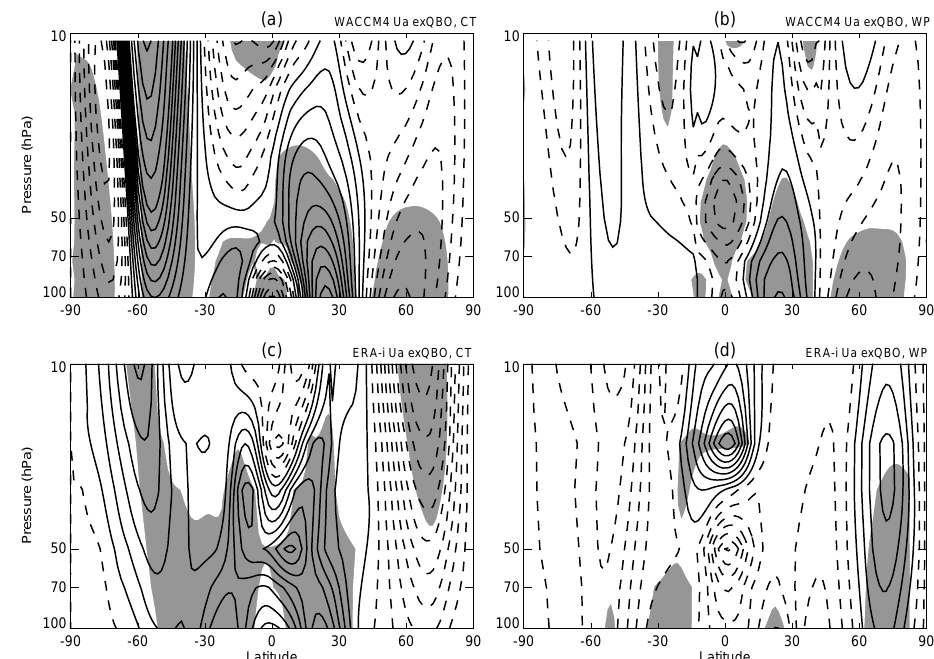
Figure 11. Differences of the zonal wind for (a) R5 – R4 and (b) R6-R4. Composite anomalies of zonal wind for (c) canonical El Niño events and (d) El Niño Modoki events, obtained using ERA-Interim data that filtered QBO (see text for details). The contour interval for zonal wind anomalies is ±0.25 m s –1 . Solid and dashed lines represent positive and negative anomalies, respectively. Anomalies that are significant at the 90% confidence level according to Student’s t-test are shaded.